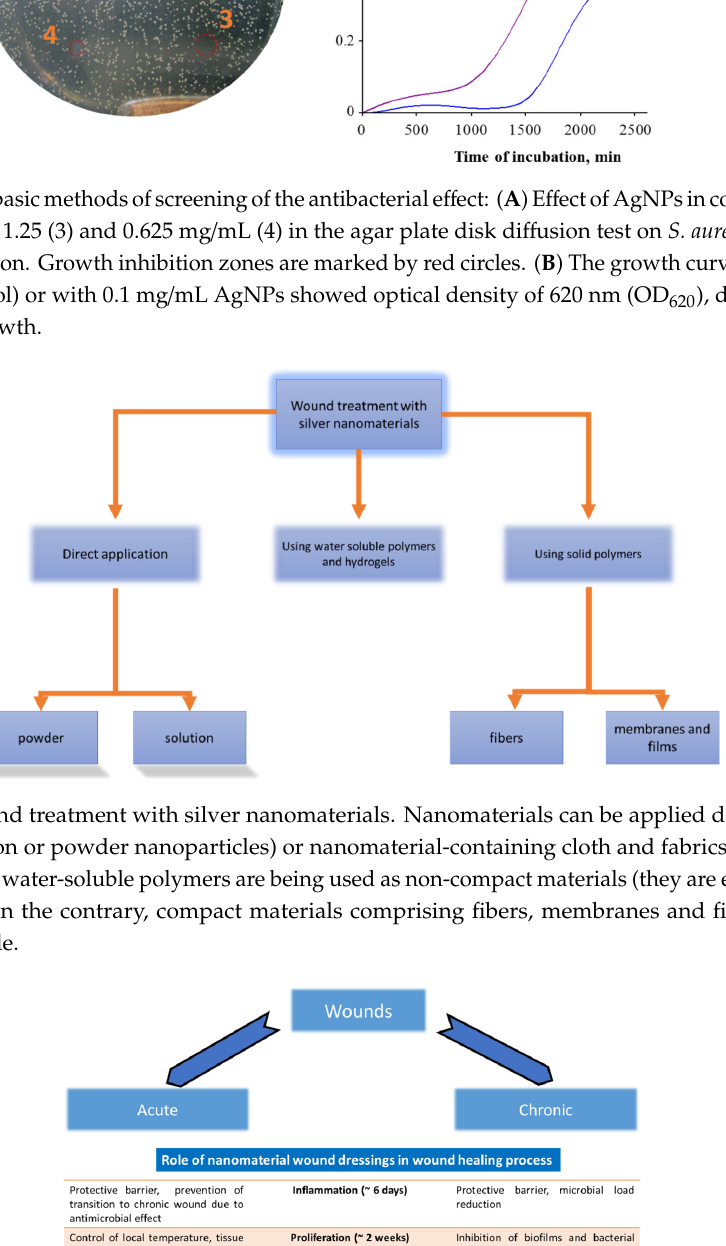
Figure 5. Summary of antimicrobial wound dressings with nanomaterials. The role of wound dressings using nanomaterials in various phases of wound healing (which comprise inflammation, proliferation and remodeling of the wound) is shown (the approximate duration of each phase is indicated in parentheses). Mostly, the effect is achieved due to the physical protection of the wound, acceleration of healing and broad antimicrobial action. Adapted from [25] under a CC BY 4.0